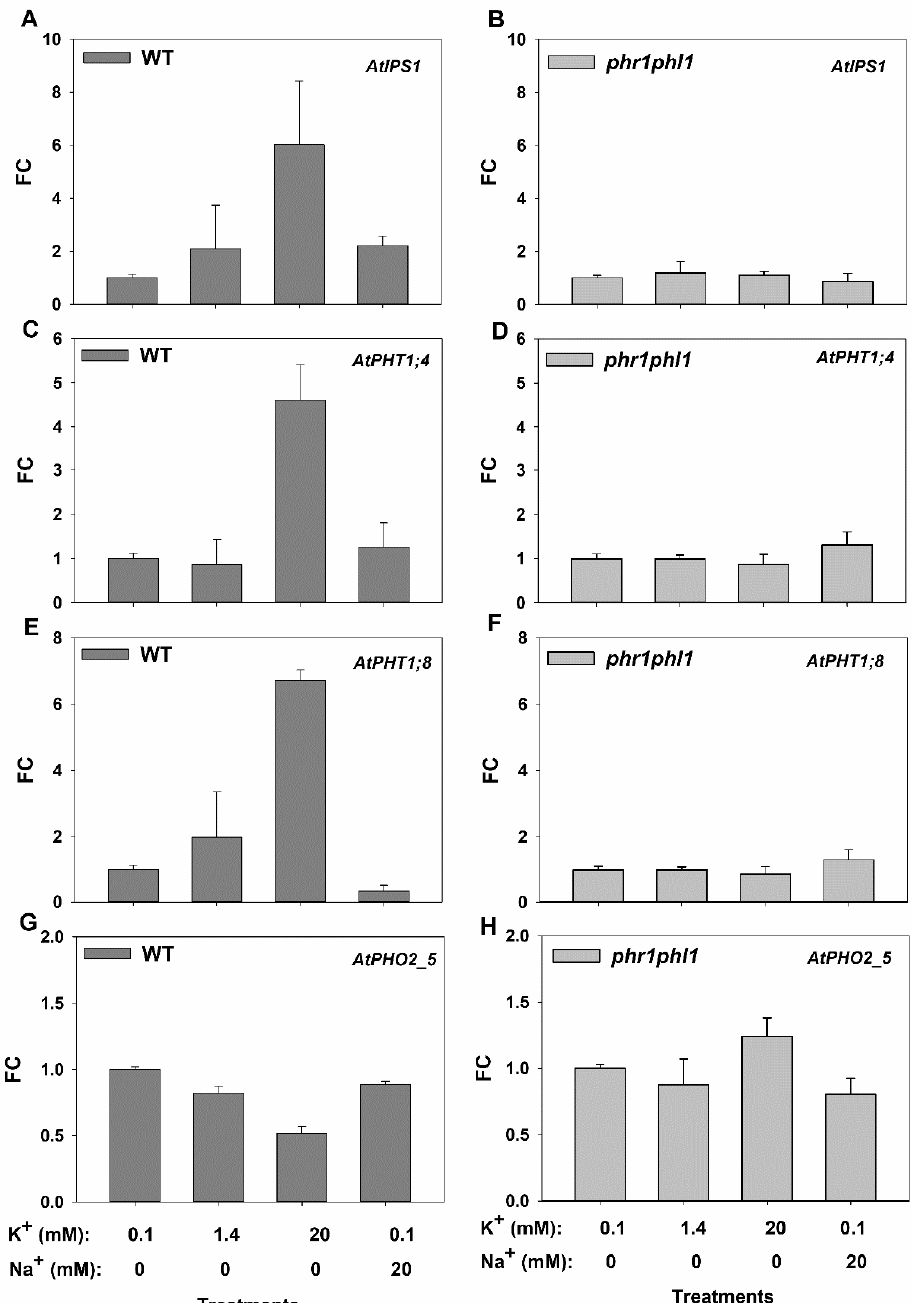
Figure 5. E ff ects of external K + and Na + on the expression of the AtIPS1 , AtPHT1.4 , AtPHT1.8 , AtPHO2_5 , AtPHR,1 and AtPHL1 genes. Plants of WT (dark grey bars) and phr1phl1 mutant (light grey bars) were grown for 33 days in a control 1 / 5 Hoagland solution and then transferred for 7 days to a solution containing 0.05 mM Pi in the presence of 0.1, 1.4, 20 mM KCl, or 0.1 mM KCl + 20 mM NaCl. Then roots were harvested and their total RNA extracted to synthesize cDNA that was used for real time PCR determinations of gene expression by the ∆∆ Ct method. ( A ) Expression of AtIPS1 in WT plants, ( B ) expression of AtIPS1 in phr1phl1 plants, ( C ) expression of AtPHT1;4 in WT plants, ( D ) expression of AtPHT1;4 in phr1phl1 plants, ( E ) expression of AtPHT1;8 in WT plants, ( F ) expression of AtPHT1;8 in phr1phl1 plants, ( G ) expression of AtIPHO2_5 in WT plants and ( H ) expression of AtIPHO2_5 in phr1phl1 plants. Shown are the averages of three repetitions for the Fold-Change of gene expression with respect to the calibrator sample corresponding to the 0.1 mM KCl